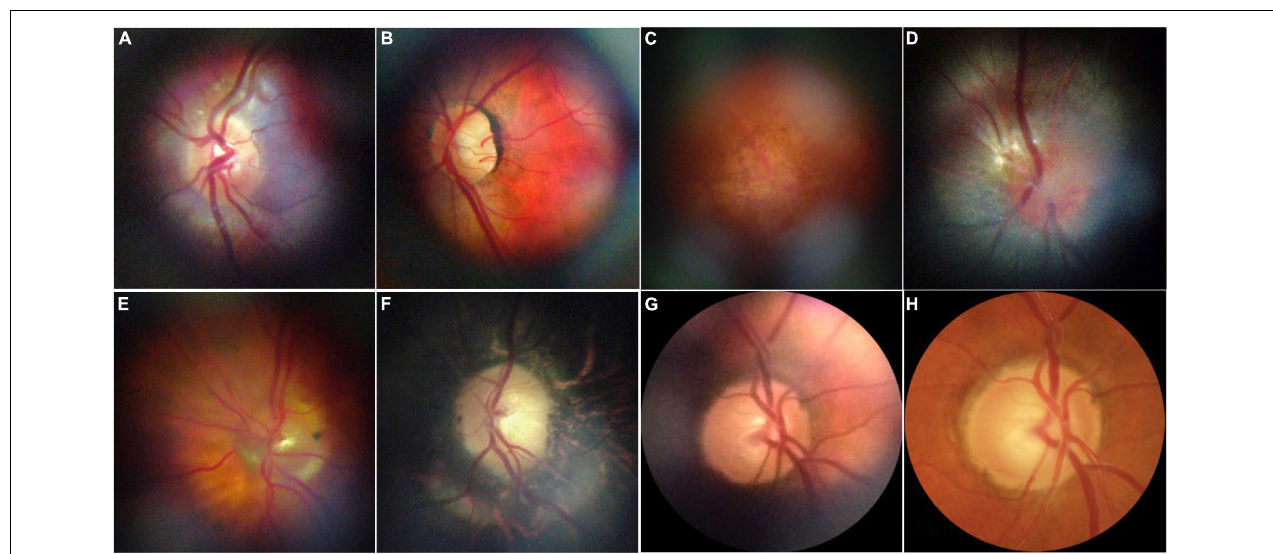
FIGURE 8 | Representative retinal images taken with D-eye. (A) A normal optic disk in an undilated child. (B) A normal posterior pole in a dilated 29-year-old woman. (C) Dry age-related maculopathy in an undilated 75-year-old man. (D) Optic nerve glioma in a 23-year-old undilated woman. (E) Posterior vitreous detachment in a dilated 72-year-old pseudophakic woman. (F) Waxy disk pallor and pigmentary changes in a 50-year-old man with retinitis pigmentosa (G,H) . Depiction of the same optic nerve head by D-Eye and Canon CR-2 Retinal Camera. This figure was reprinted from Russo et al. (434) with permission.